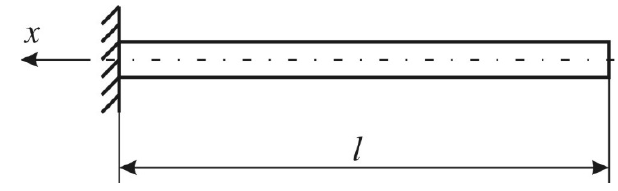
Fig. 1. Geometrical model for the